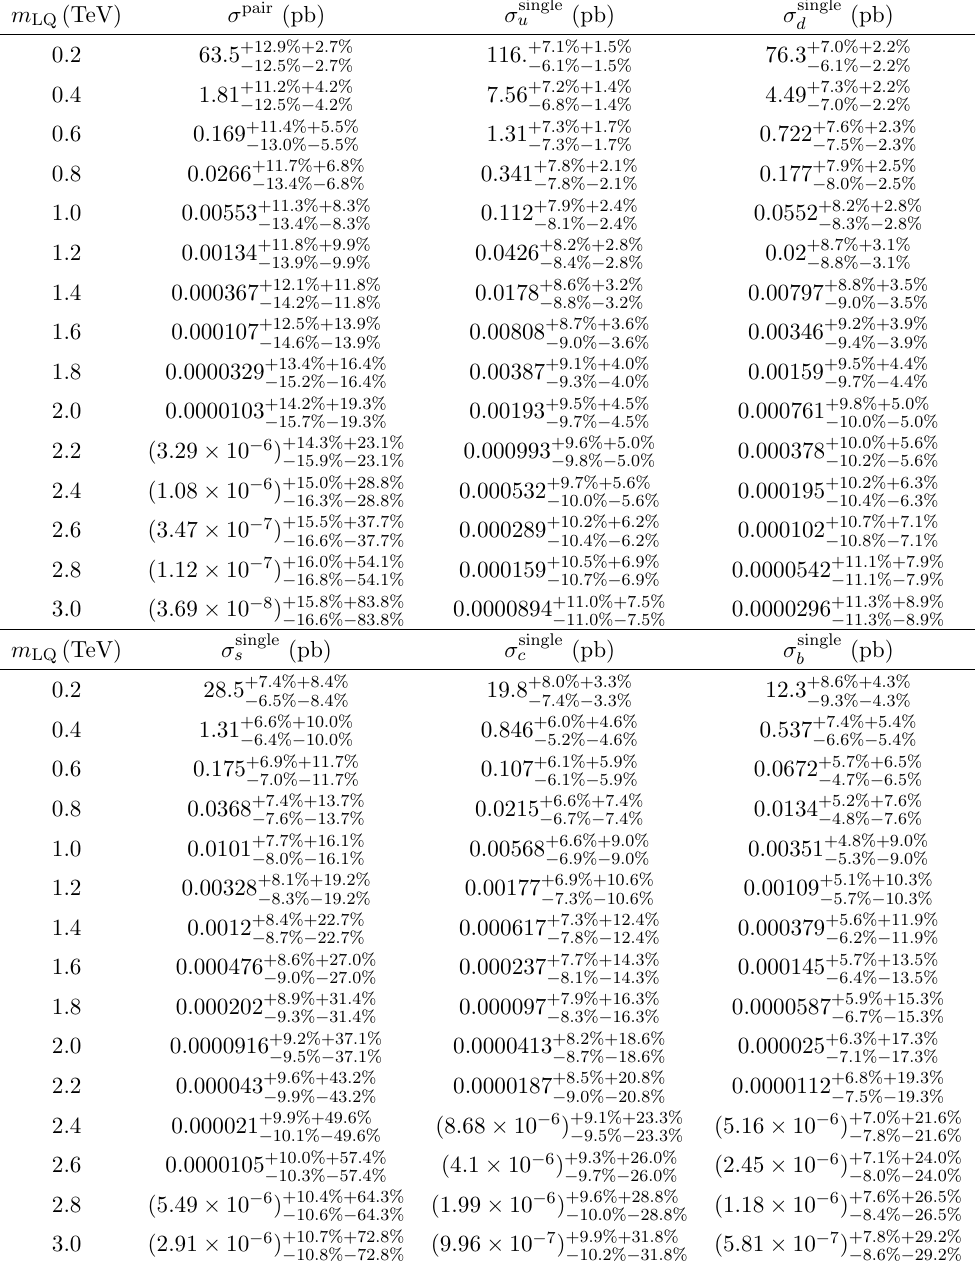
Table 1 . Total inclusive cross sections in pb for the PDF4LHC15 PDF sets [29] as a function of the LQ mass at 13 TeV center-of-mass energy for the proton-proton collisions. (cid:27) pair corresponds to the LQ pair production. (cid:27) single describe single LQ production cross sections through corresponding u;d;s;c;b quark (cid:13)avour when the associated Yukawa coupling strength is set to one. The cross section dependancy on the change in the renormalisation ( (cid:22) R ) and factorisation ( (cid:22) F ) scales is taken into account through the following scale variations: (cid:22) R = (cid:22) F = m LQ = 2 ; m LQ ; 2 m LQ . First (second) uncertainty is due to the renormalisation (cid:22) R and factorisation (cid:22) F scale (PDF) variations and is given in per cent